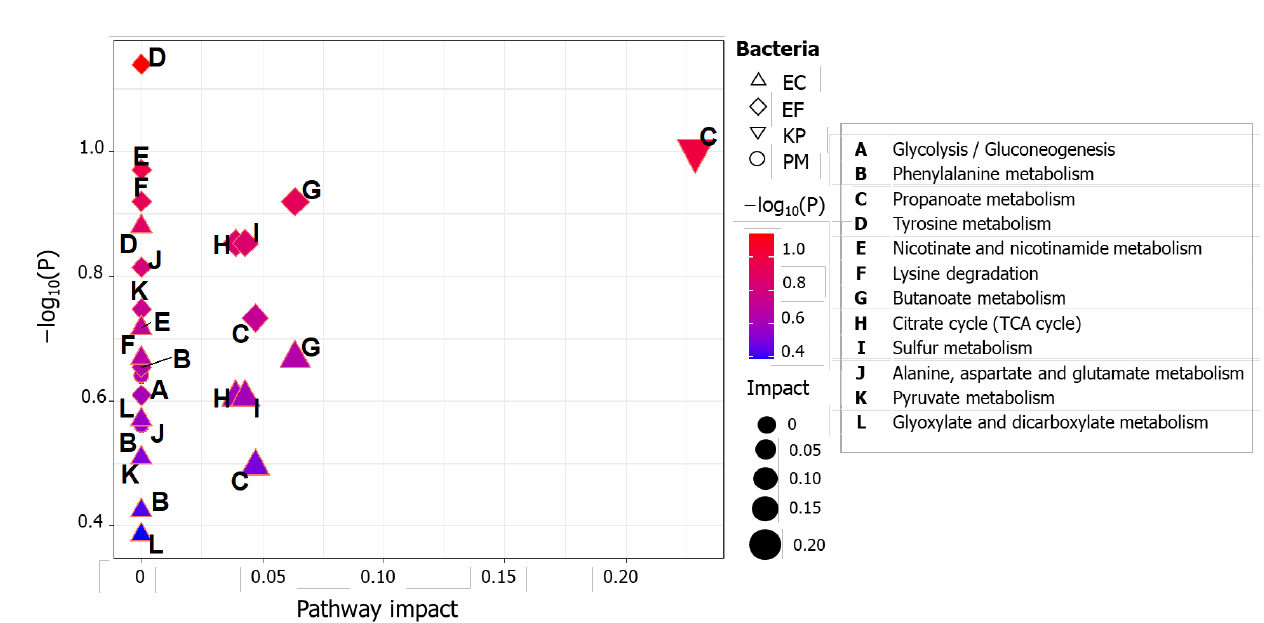
Figure 7. Pathway topology analysis based on KEGG-described paths. EC = E. coli , EF = E. faecalis , KP = K. pneumoniae , PM = P. mirabilis .